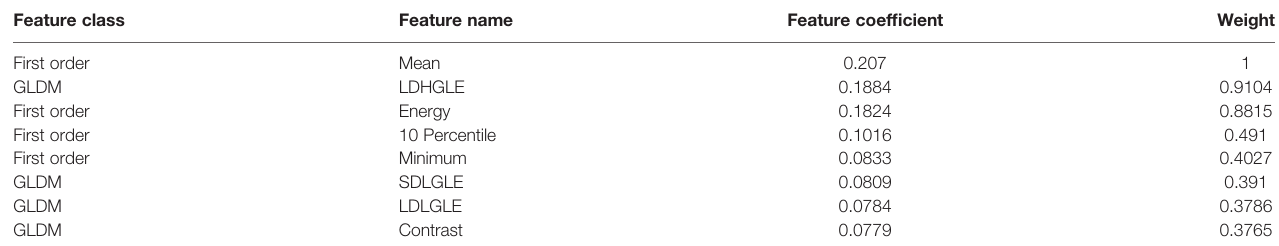
TABLE 3 | Selected radiomic features for the prediction model